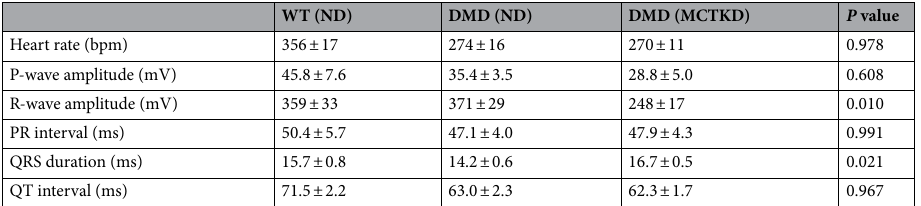
Table 1. Electrocardiogram results. Values are the mean ± SEM (n = 6 for ND-fed DMD rats, n = 6 for MCTKD-fed DMD rats, n = 4 for WT rats). P values indicate the results of one-way ANOVA followed by the Tukey–Kramer multiple comparison test between 2 groups of DMD (ND) and DMD (KD). DMD = Duchenne muscular dystrophy, MCTKD = medium-chain triglycerides containing ketogenic diet, ND = normal diet, WT = wild